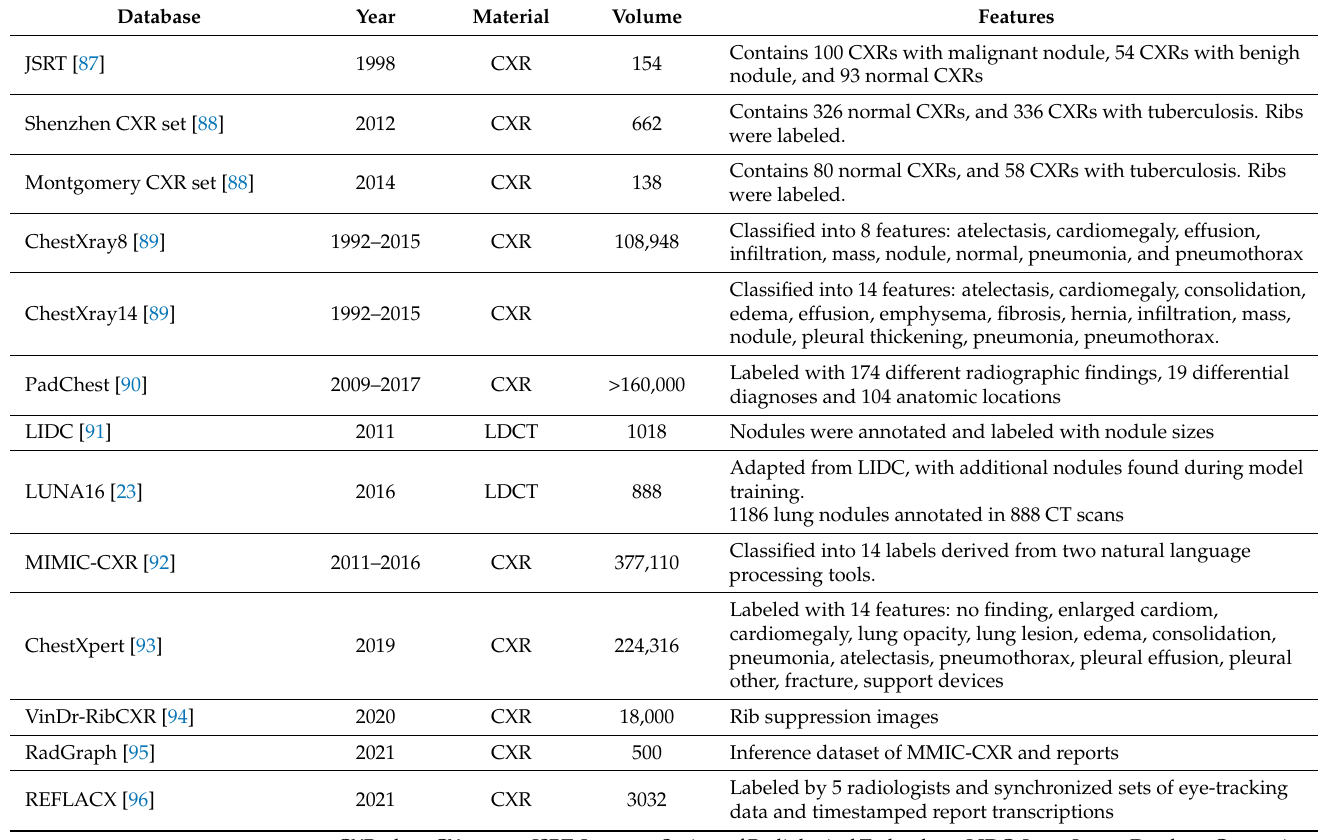
Table 2. Summary of frequently used datasets for model